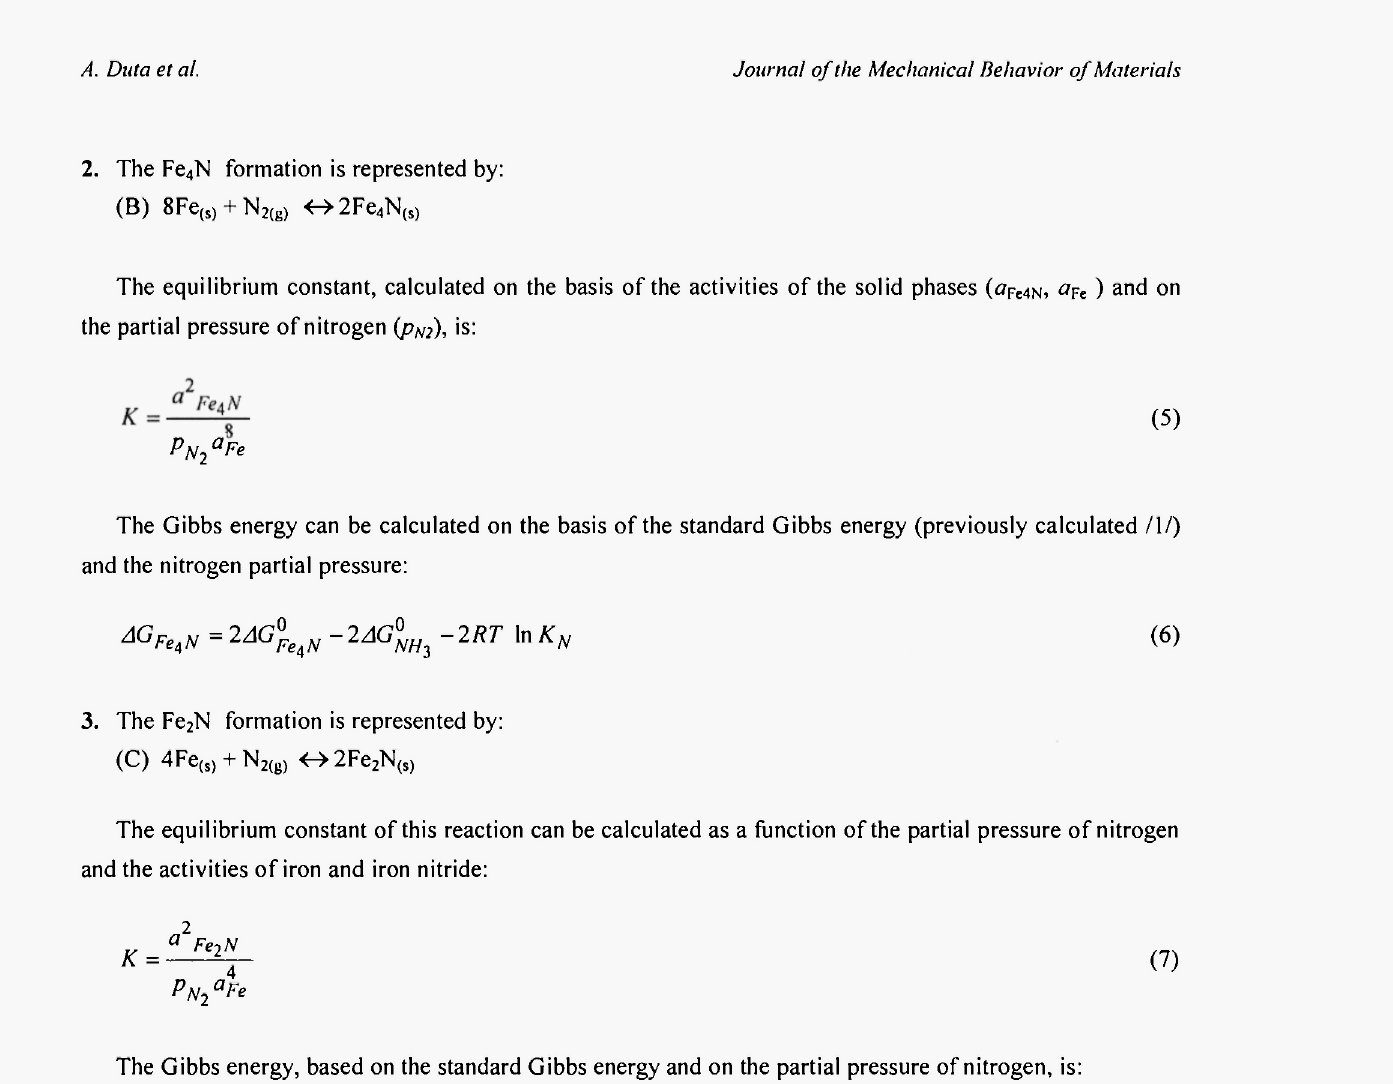
Thermodynamic parameters of the